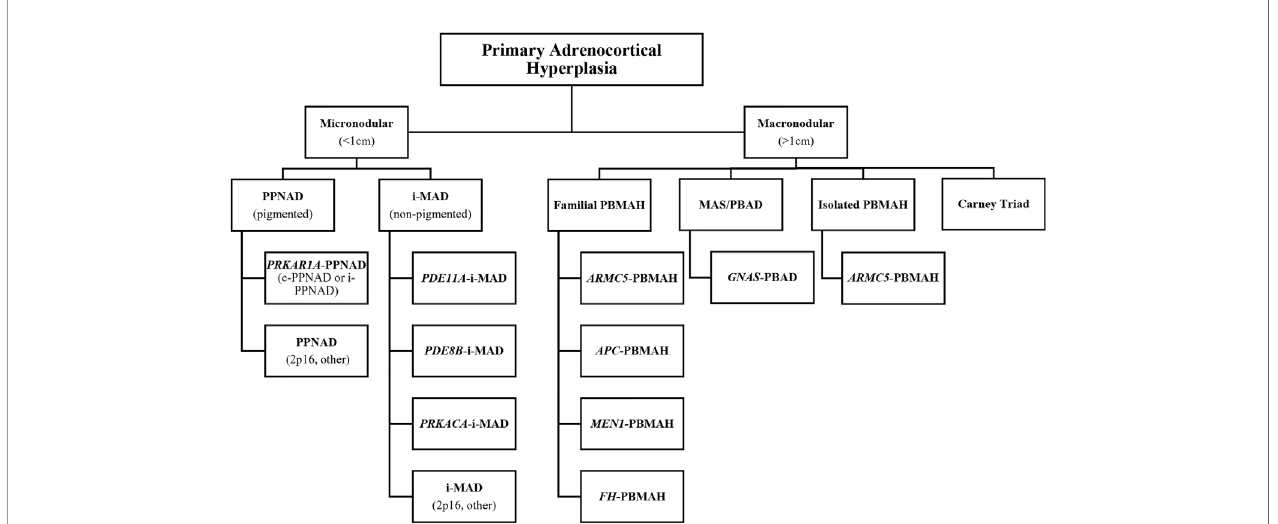
FIGURE 3 | Gene-based diagnostic algorithm for primary cortisol-producing adrenocortical hyperplasias. * APC, adenomatous polyposis coli gene; ARMC5, armadillo repeat-containing protein 5; c-PPNAD, CNC-associated primary pigmented nodular adrenocortical disease; CNC, Carney complex; FH, fumarate hydratase; GNAS, gene coding for the stimulatory subunit a of the G-protein (Gs a ); i-MAD, isolated micronodular adrenocortical disease; i-PPNAD, isolated PPNAD; MAS, McCune – Albright syndrome; MEN1, multiple endocrine neoplasia type 1; PBAD, primary bimorphic adrenocortical disease; PBMAH, primary bilateral macronodular adrenocortical hyperplasia; PDE8B, phosphodiesterase 8B gene; PDE11A, phosphodiesterase 11A gene PPNAD, primary pigmented nodular adrenocortical disease; PRKACA, protein kinase, cAMP-dependent, catalytic, alpha; PRKAR1A, protein kinase, cAMP-dependent, regulatory, type I, a gene. *Adapted from Kamilaris CDC, Stratakis CA, Hannah-Shmouni F: Adrenocortical tumorigenesis: Lessons from genetics. Best Practice & Research Clinical Endocrinology & Metabolism 2020,34(3):101428.